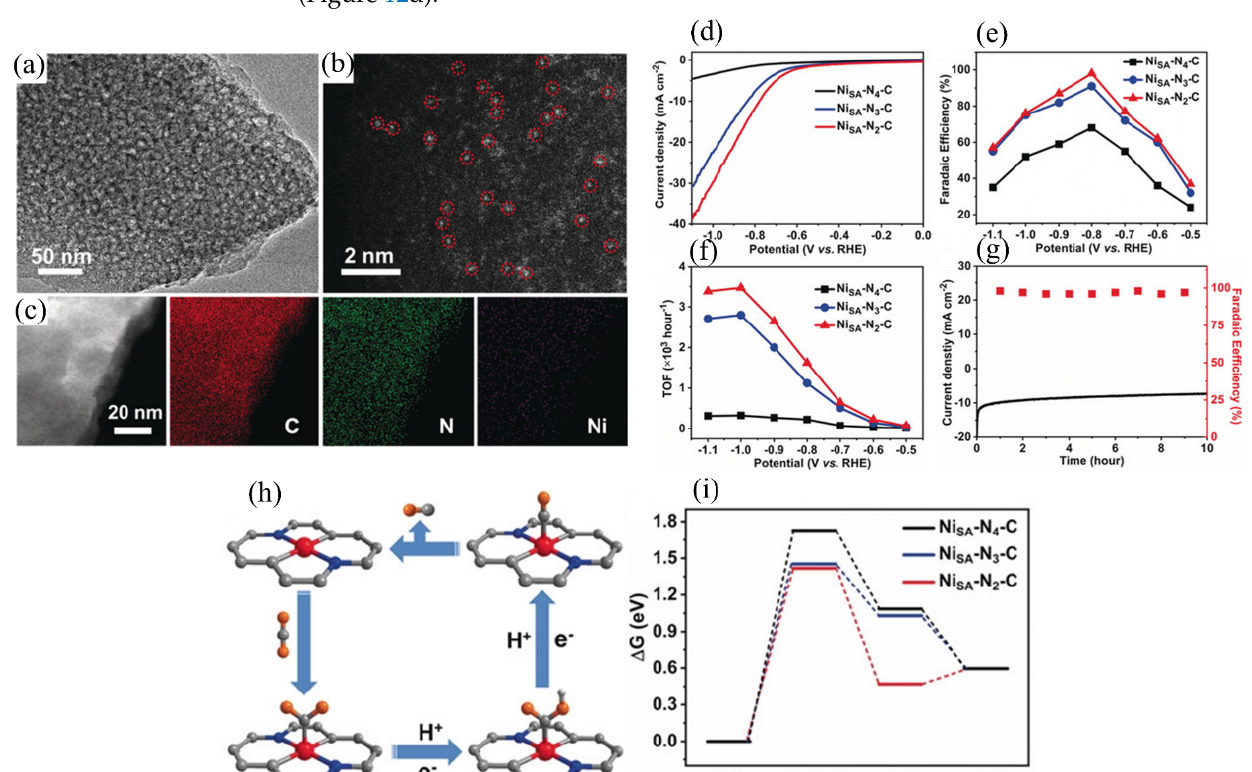
Figure 11. ( a ) Transmission electron microscope (TEM) and ( b ) HAADF-STEM images of NiSA–N 2 –C. ( c ) EDS mapping of Ni, N and C elements in NiSA–N 2 –C. ( d ) LSV curves in CO 2 -saturated 0.5 M KHCO 3 electrolyte. ( e ) FEs of CO at different applied potentials. ( f ) The corresponding TOFs of CO